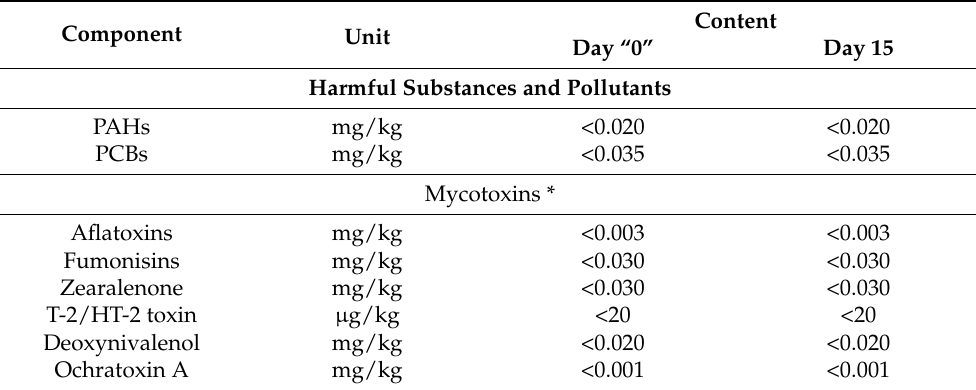
Figure 4. Moisture content of biomass during (day 0–5, 10, 15) SSF of GP by R. oryzae in laboratory jars and tray bioreactor. Table 4. PAHs, PCBs, and mycotoxins analysis in grape pomace before (day “0”) and after 15 days of SSF by R. oryzae in tray